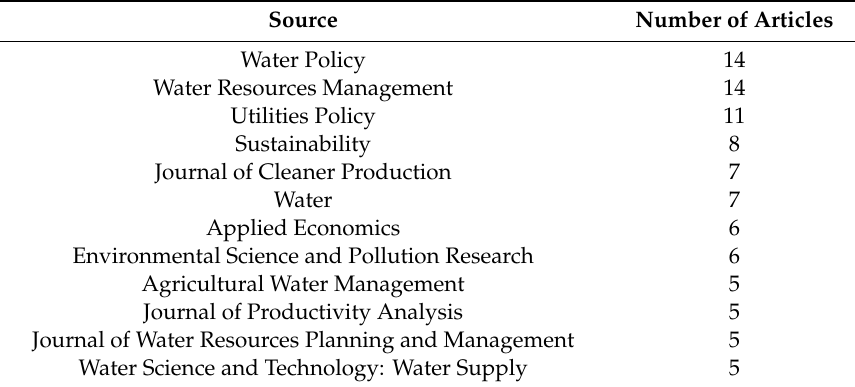
Table 4. Most relevant